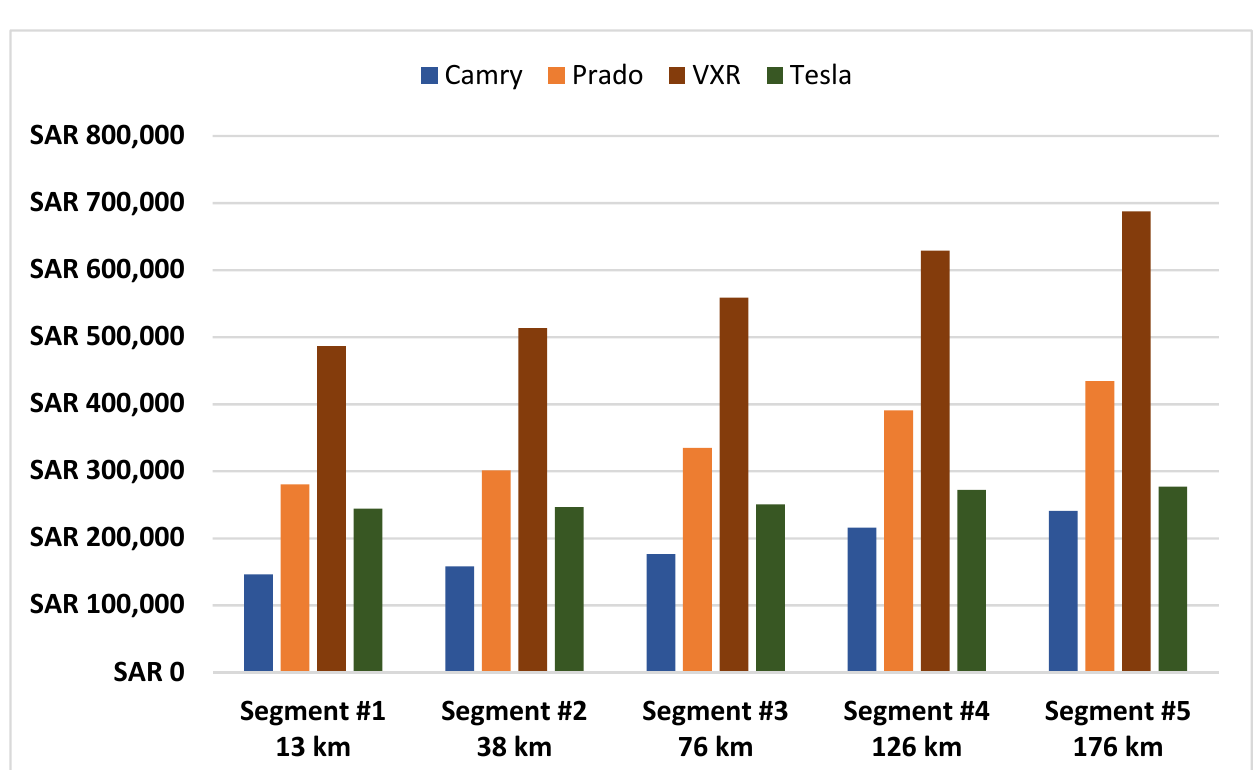
Figure 9. Cost of ownership of EVs and ICEVs over a 10-year period.